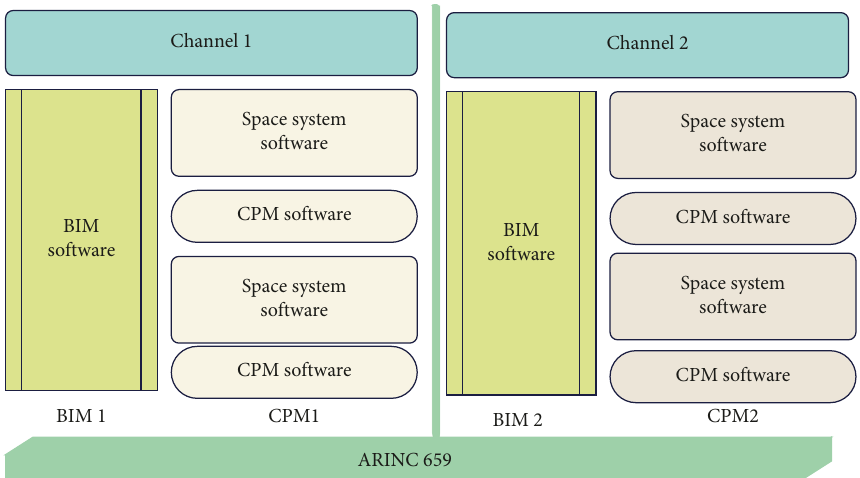
Figure 8: Structure diagram of comprehensive management computer